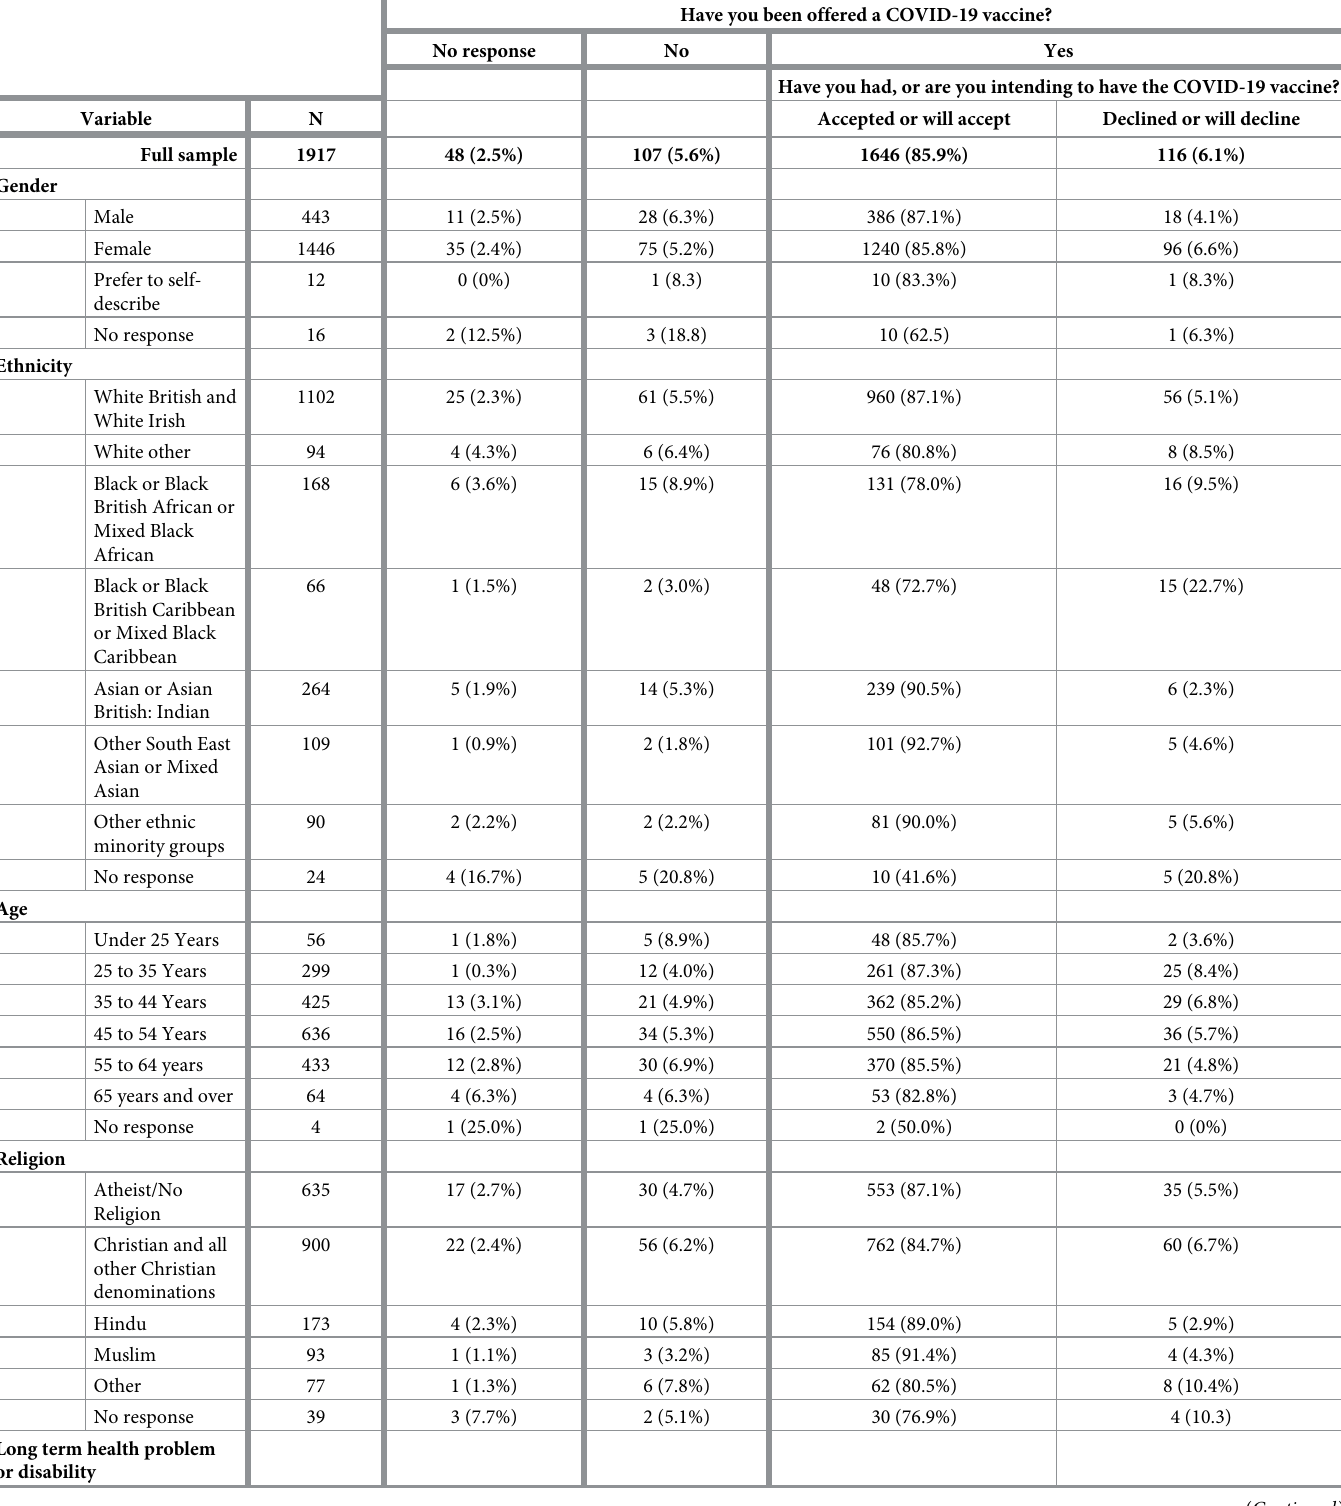
Table 2. Participants demographic characteristics by being offered a vaccine and vaccine